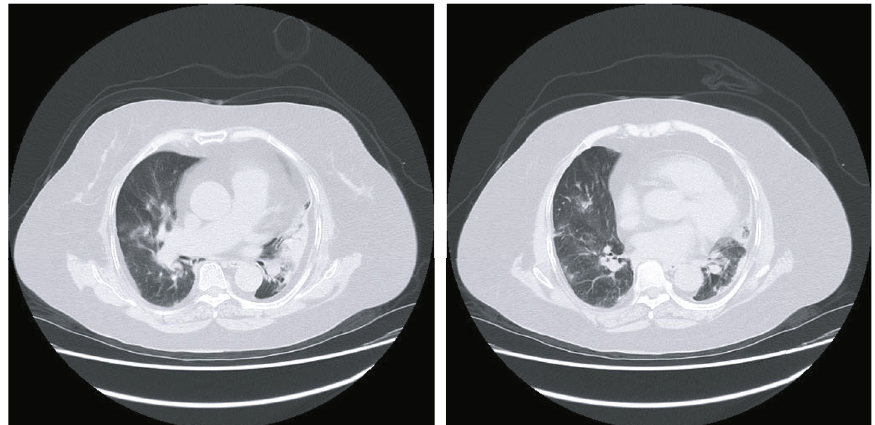
Figure 1: Chest computed tomography on admission to hospital. Scattered ground-glass opacities immediately below the right pleura and atelectasis in the left lower lung fi eld are